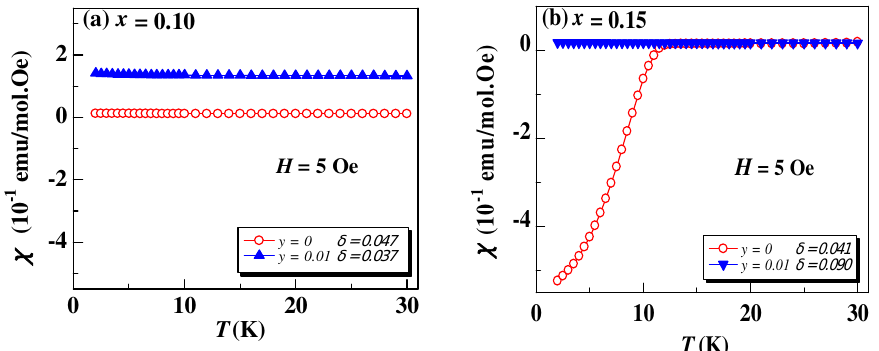
Figure 4. The magnetic susceptibility ( χ ) in field cooled in H = 5 Oe versus temperature for (cid:5)